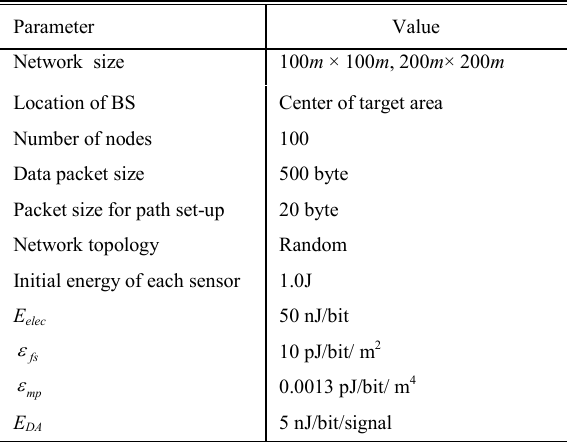
Table 1. The parameters used in the simulation. Parameter